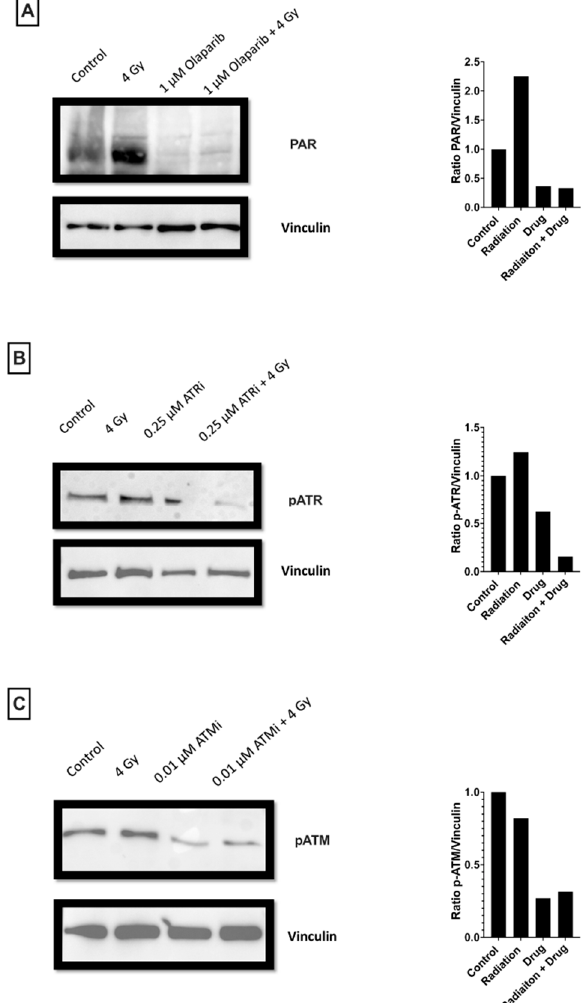
Figure 10. Effect of ( A ) olaparib, ( B ) AZD6738 and ( C ) AZD0156 on target proteins of respective DNA repair pathways in MCF-7 cells. Olaparib directly affects the protein levels of PAR. AZD6738, an ATR inhibitor, directly affects the phosphorylation of ATR. AZD0156, an ATM inhibitor, directly affects the phosphorylation of ATM. Phosphorylation or protein levels were evaluated for control cell populations only treated with DMSO, cells only treated with 4 Gy of radiation, cells only treated with DDR inhibitors, or cells treated with a combination of both. Levels of Vinculin were used as a loading control, and quantification was performed with ImageJ. Protein ratios were normalized to the untreated control cells.